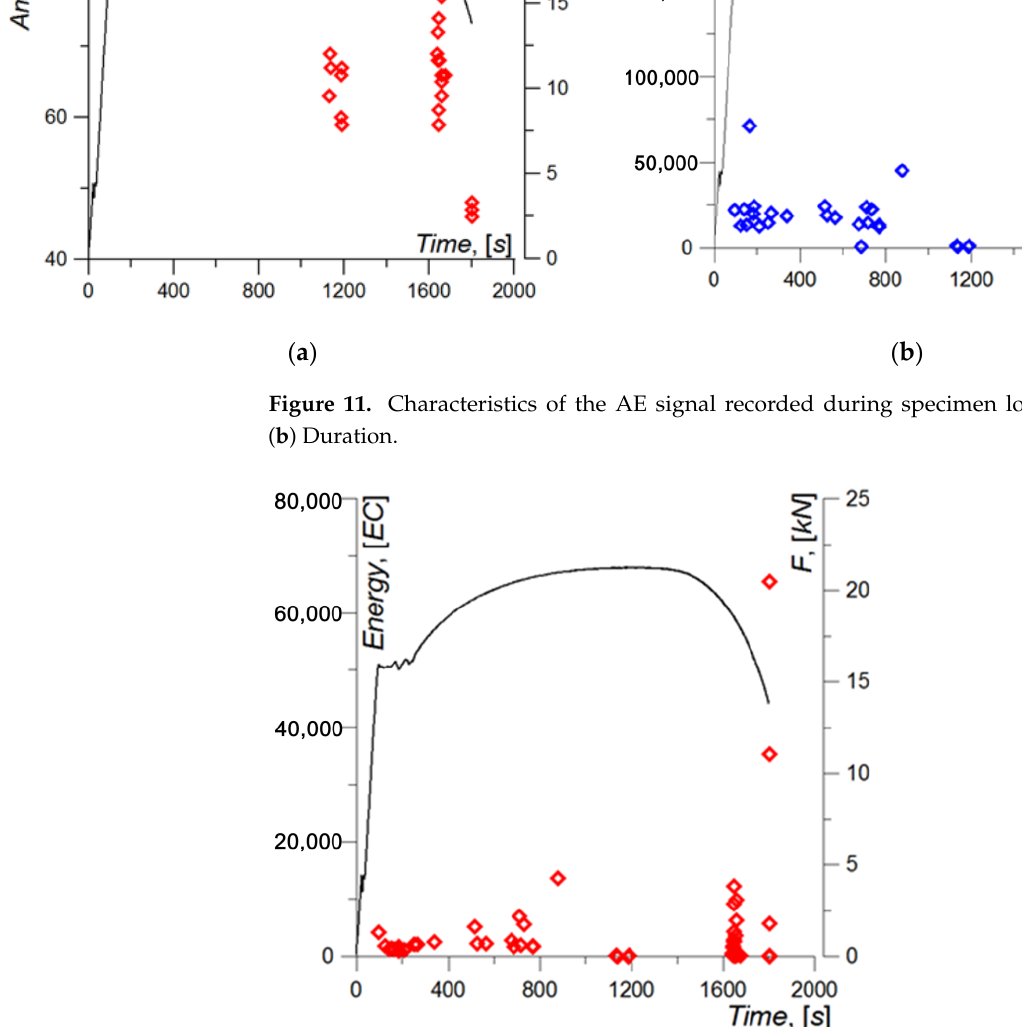
Figure 12. Energy AE parameter recorded during specimen loading.